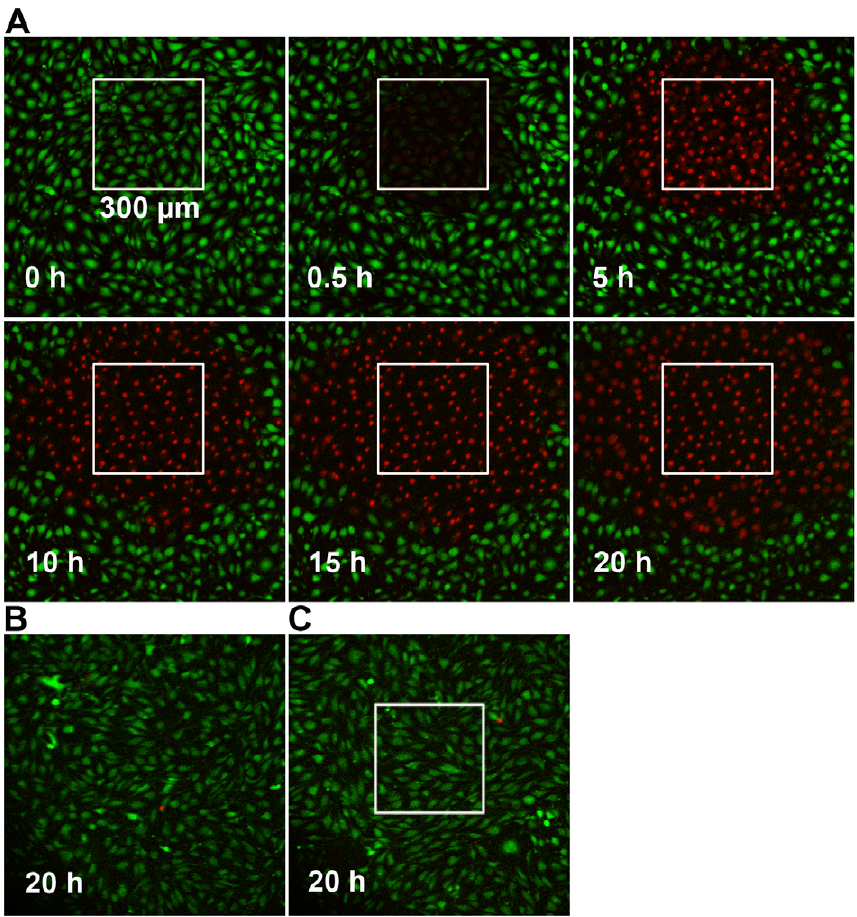
Figure 1. Propagation of cell death following COI. A – bEnd.3 monolayers were subjected to COI. Cell death was monitored by changes in the fluorescence of membrane viability probes, CaAMg and PI, as followed by TLFM. Dead cells are defined as CaAMg negative (green), PI positive (red). Time zero represents termination of COI. B – Dark control (with WST11, no illumination). C – Light control (Illumination, of same rectangle, no WST11). Both control images were taken at 20h. All other details are as described in the Materials and Methods